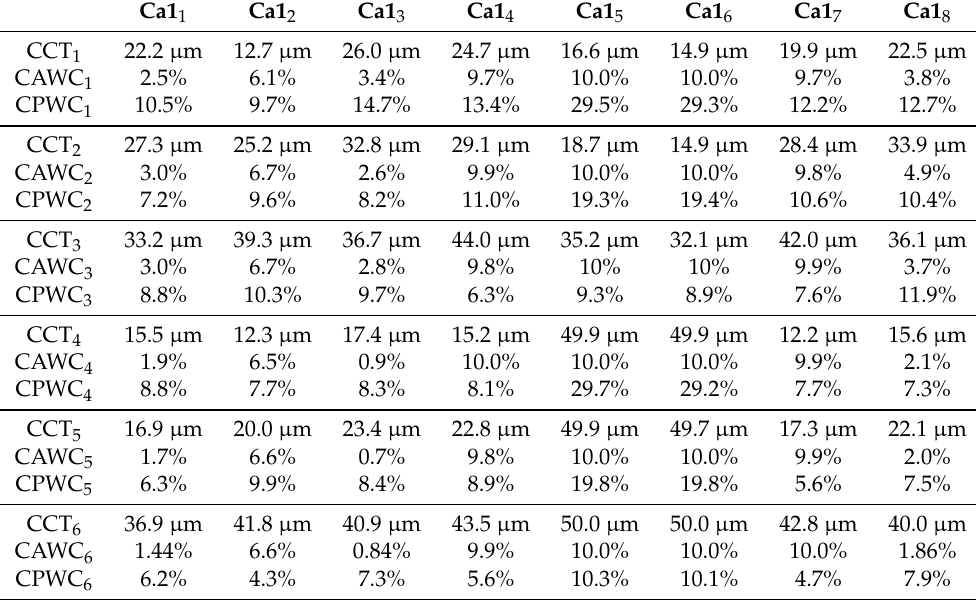
Table 2. RMSD of estimated CCT, CAWC, and CPWC for six noisy cornea calibrated with various noisy perturbed PEC sphere at frequency band of WR 5.1. The SNR 60 dB is considered.